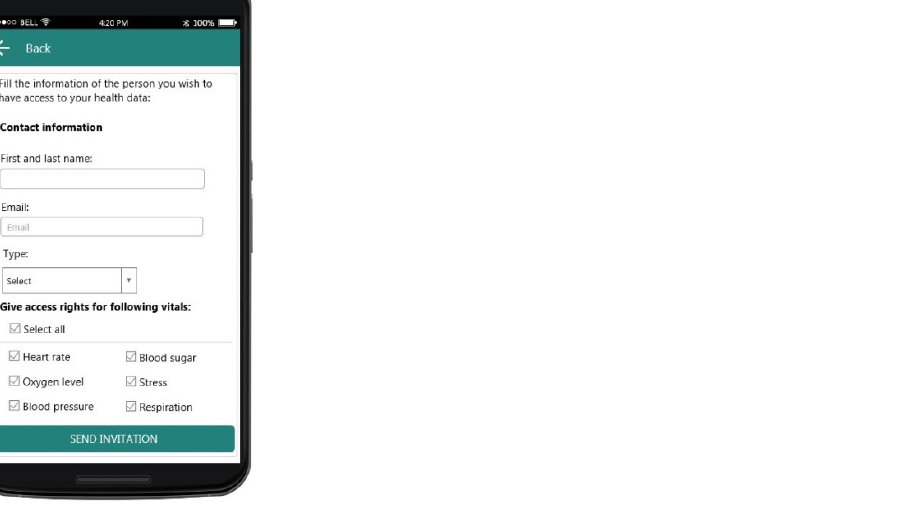
Figure 13. Create a contact invitation screen. The user selects the vital signs the invited contact will have access rights to.